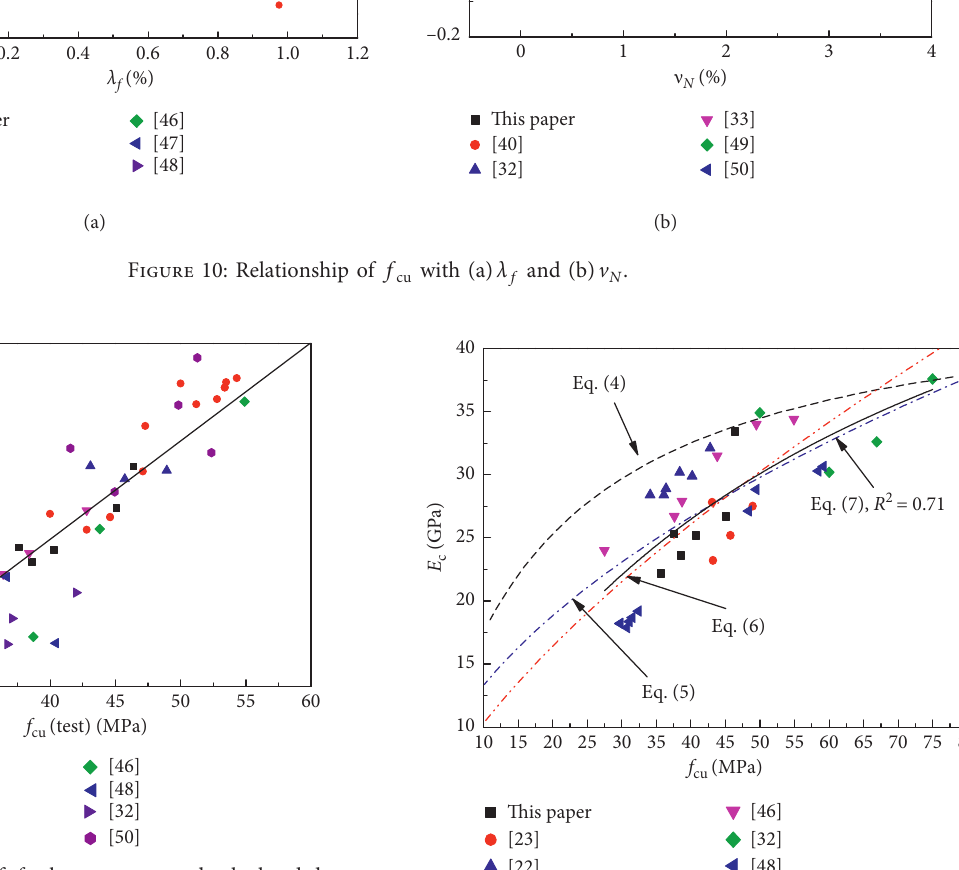
between test and calculated data. cu